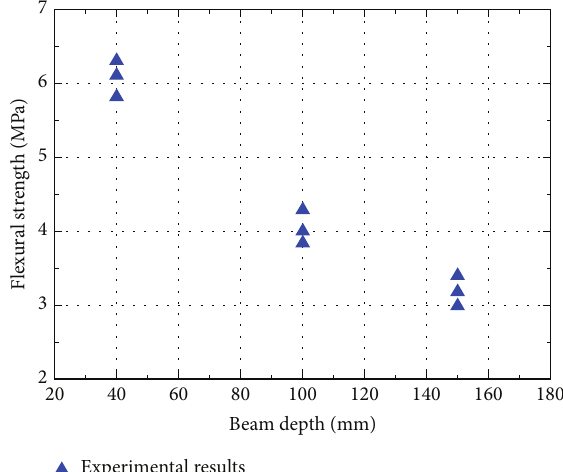
Figure 5: Influence of beam size on flexural strength of cement mortar.